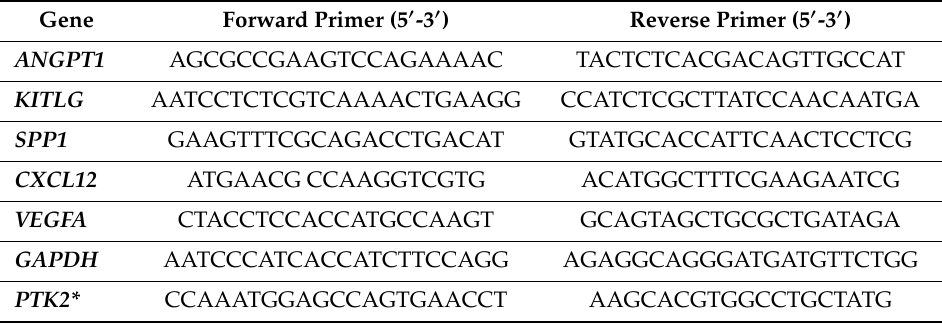
Table 3. Real-time PCR primer